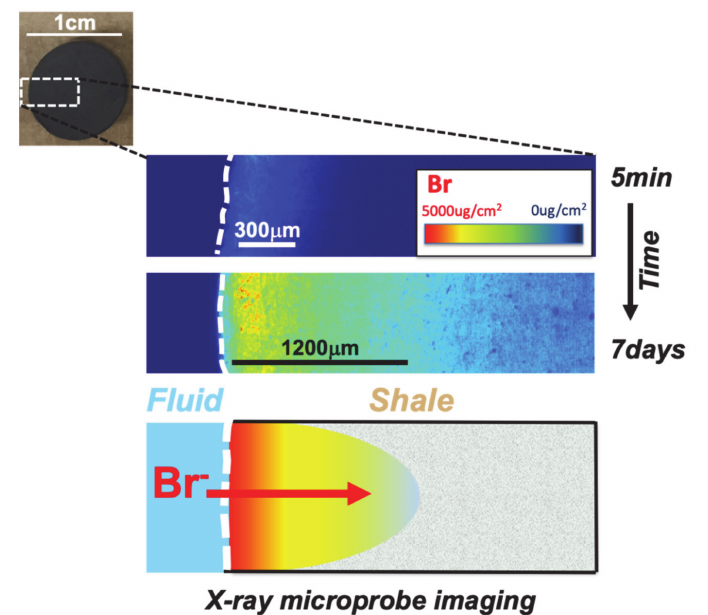
Figure 17. X-ray mapping of a low-reactivity Br tracer added in the frac fluid to map fluid penetration and gain insights about ion transport and chemical reactions occurring in shale. The inset at the top shows a core slice that was imaged using this method. The imaged sections show heat maps of the estimated mass of bromide in each pixel. After 5 min, fluid has penetrated about 300 µ m. After 7 days, the fluid has imbibed throughout the core and has accumulated near the fracture